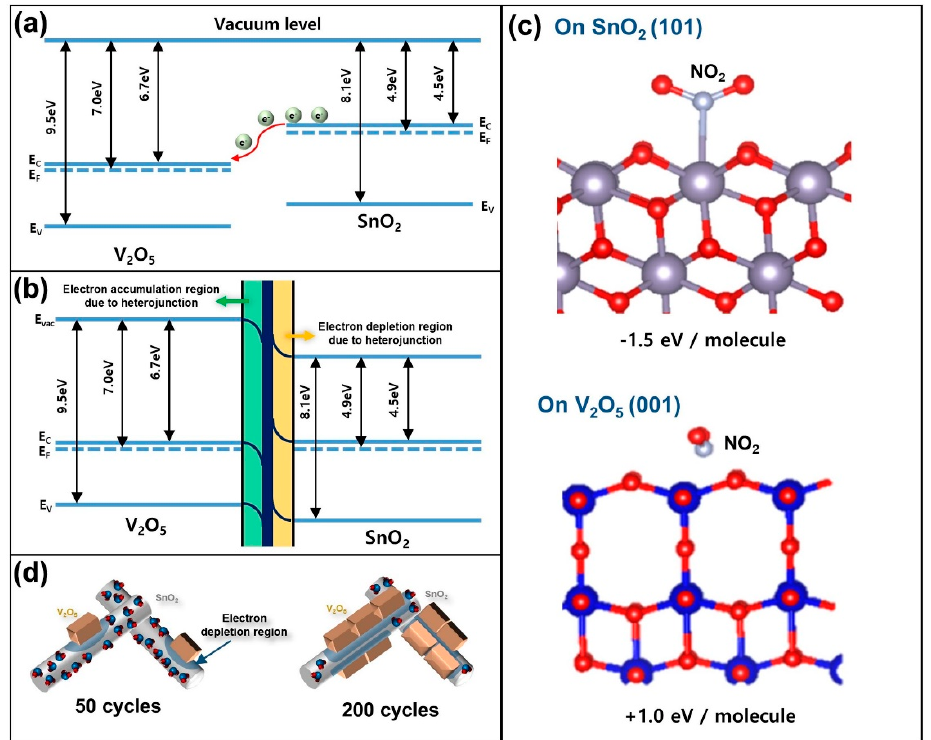
Figure 8. ( a,b ) Energy band diagrams of SnO 2 -V 2 O 5 before and after contact in air. ( c ) NO 2 adsorption on SnO 2 (101) V 2 O 5 (001) surfaces. ( d ) Effect of number of ALD cycles and amount of V 2 O 5 on the surface of SnO 2 [67].